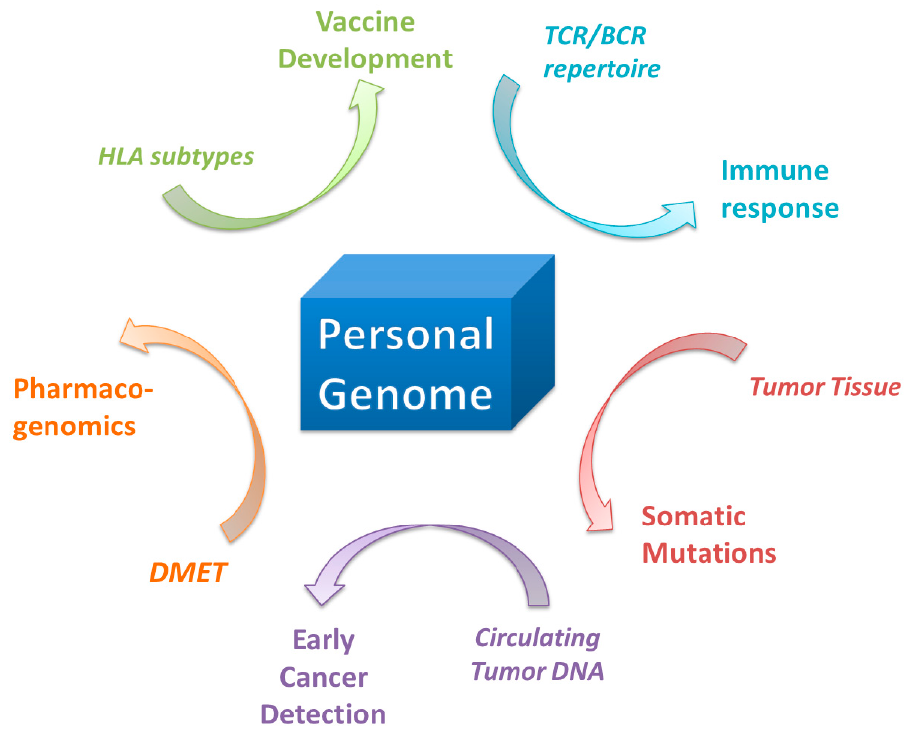
Figure 2. Potential use of a personal genome in future clinical settings.